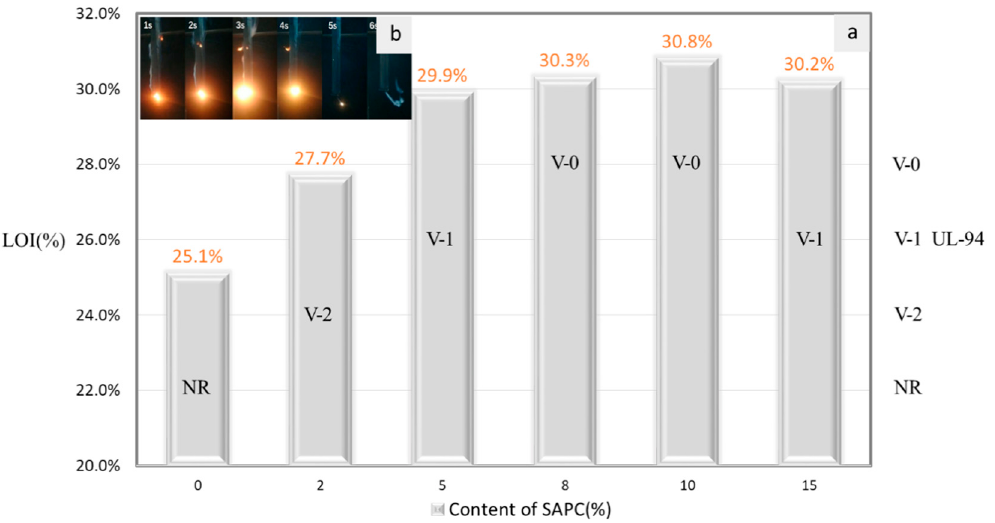
Figure 5. ( a ) The limiting oxygen index (LOI) and vertical combustion analysis of EP/SAPC composites; ( b ) “blowout” digital photos in vertical burning test.